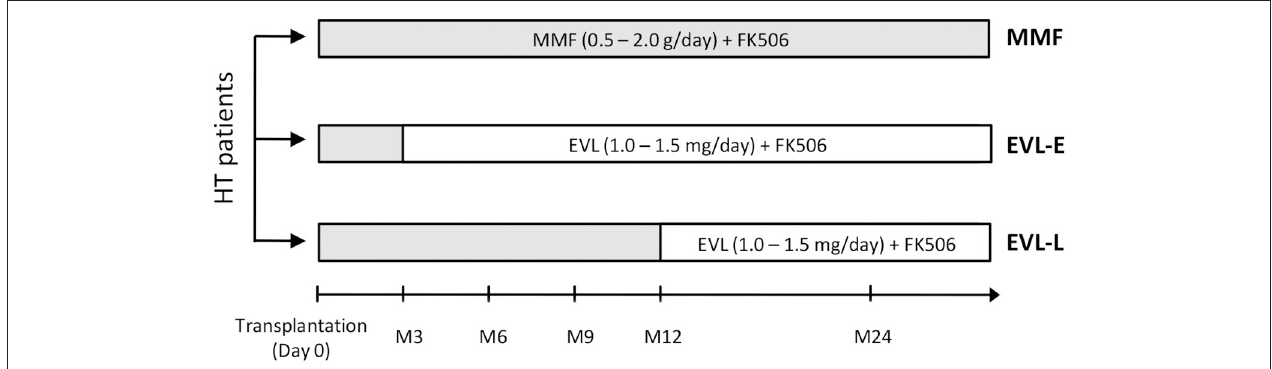
FIGURE 1 | Design of the retrospective study. HT (heart transplant) patients enrolled with respect to the immunosuppressant treatment and the timing of EVL initiation. MMF group ( n = 20), patients under MMF treatment; EVL-E group ( n = 12), patients converted to EVL 3 months after HT; EVL-L ( n = 8), patients converted to EVL > 1 year after HT. MMF, mycophenolate mofetil; EVL, everolimus.